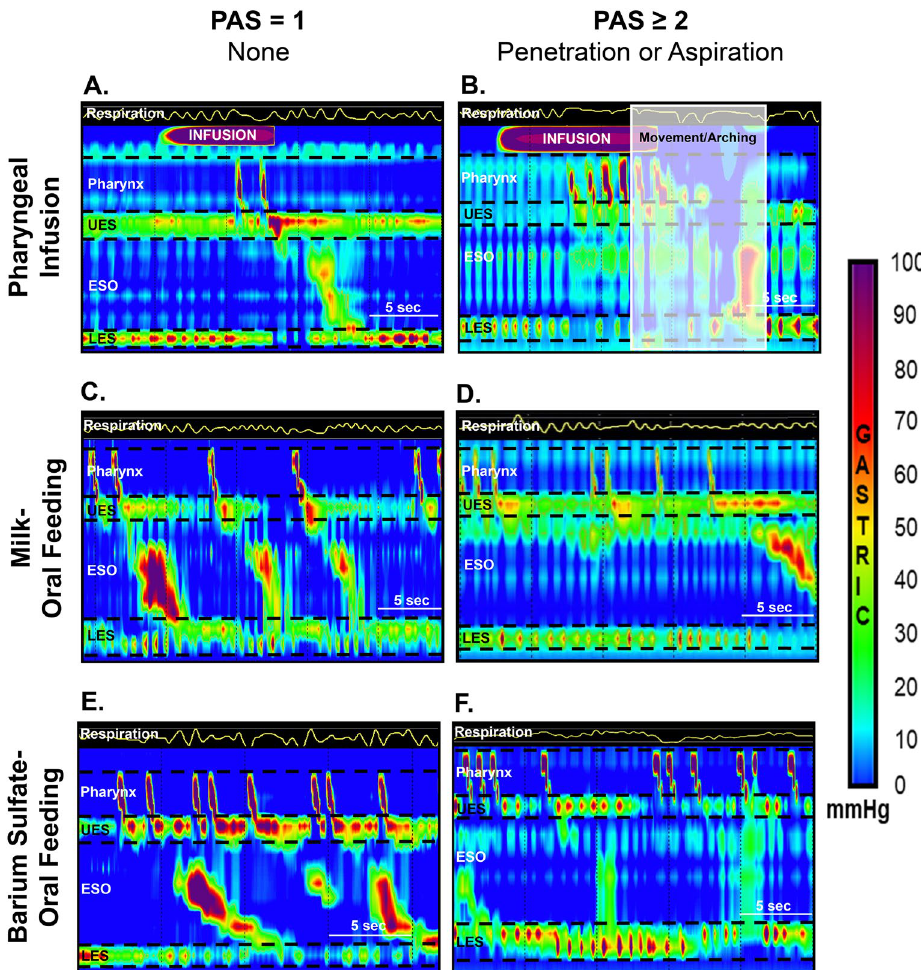
Figure 4. Motility correlates during pharyngeal infusion, oral feeding with milk, and oral feeding with barium sulfate of infants with and without penetration or aspiration. UES- upper esophageal sphincter, ESO- esophagus, LES- lower esophageal sphincter. Shown are representative esophago-pressure topography plots during HRM. Significantly, note in infants with penetration or aspiration symptoms are increased during pharyngeal infusion ( A,B ) and esophageal contractions are weaker during oral feeding with barium sulfate ( E,F ). Also note, stronger pharyngeal vigor during barium-sulfate oral feeding ( E,F ) vs milk oral feeding ( C,D